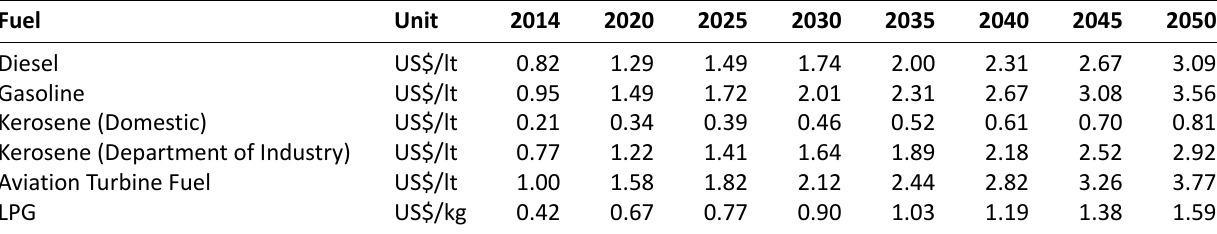
Table A13. Fuel price projection, based on Department of Renewable Energy (2015a) and US Energy Information Adminis- tration